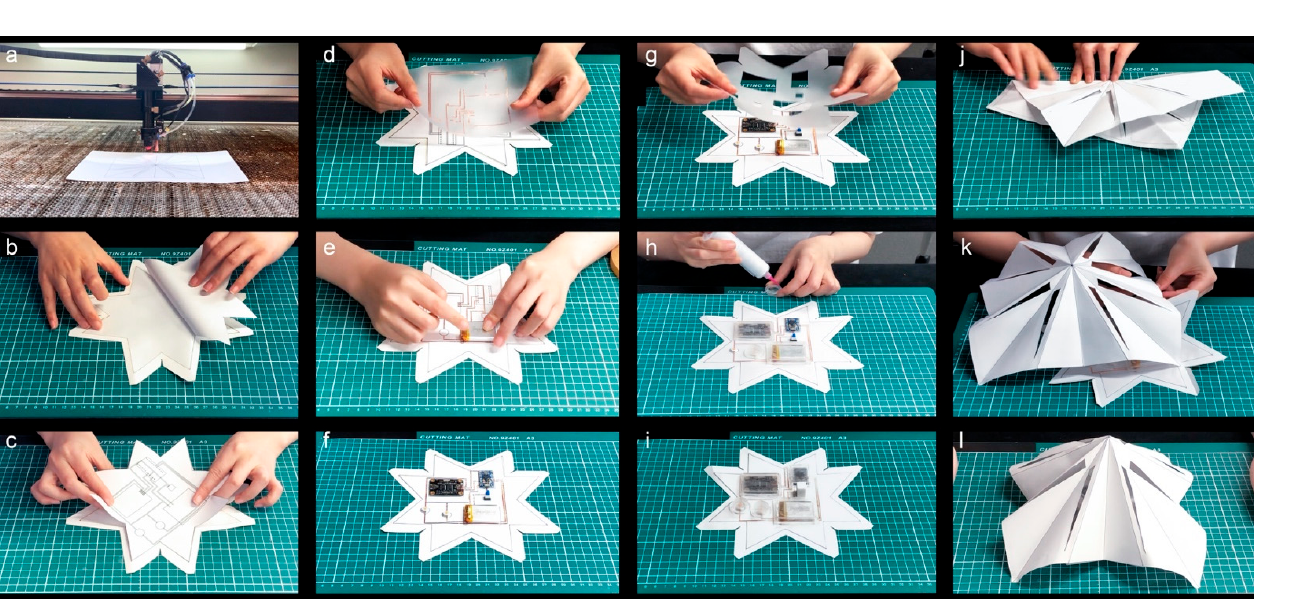
Figure 11. Fabrication: ( a ) print and cut; ( b ) remove the inner part of the protected paper; ( c ) paste the hardware distribution layer on the sticky side of the waterproof layer; ( d – f ) circuit fabrication; ( d ) copper wire transfer; ( g – i ) superpose layers; and, ( j – l ) fold and assembly.